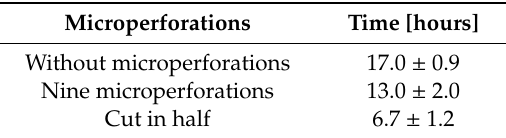
Table 2. Primary drying time of blueberry freeze-drying as a ff ected by CO 2 laser microperforations and cut-in-half